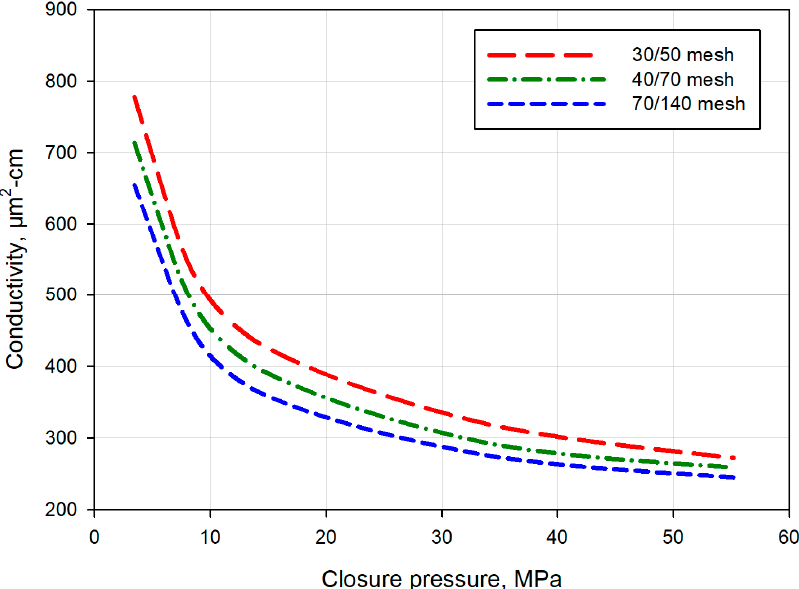
Figure 13. Conductivity evolution of fishbone intersecting pattern fractures with different sizes of proppants.